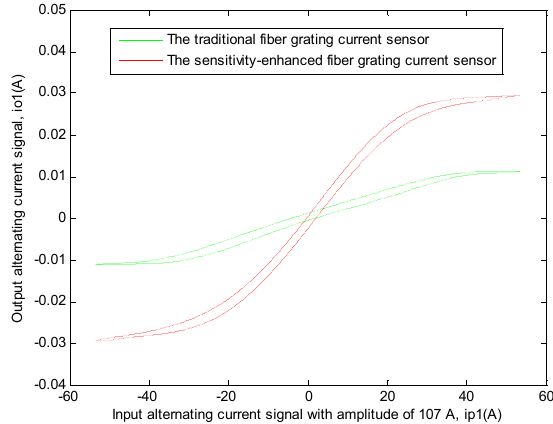
Figure 9. The transfer function relationship curves of the two sensors between output alternating current signal ( i o 1 ) and input alternating current signal with amplitude of 107 A ( ip o 1 ), respectively. The red curve shows the transfer function relationship of the sensitivity-enhanced fiber grating current sensor. The green curve shows the transfer function relationship of the traditional fiber grating current sensor.